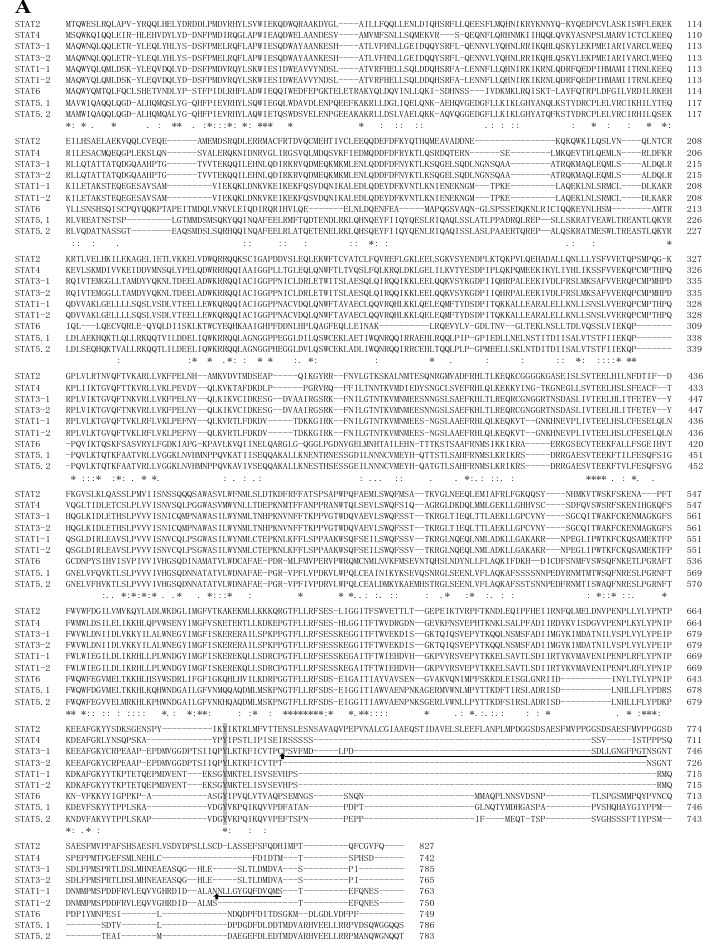
Figure 2. Cont. Figure 2.